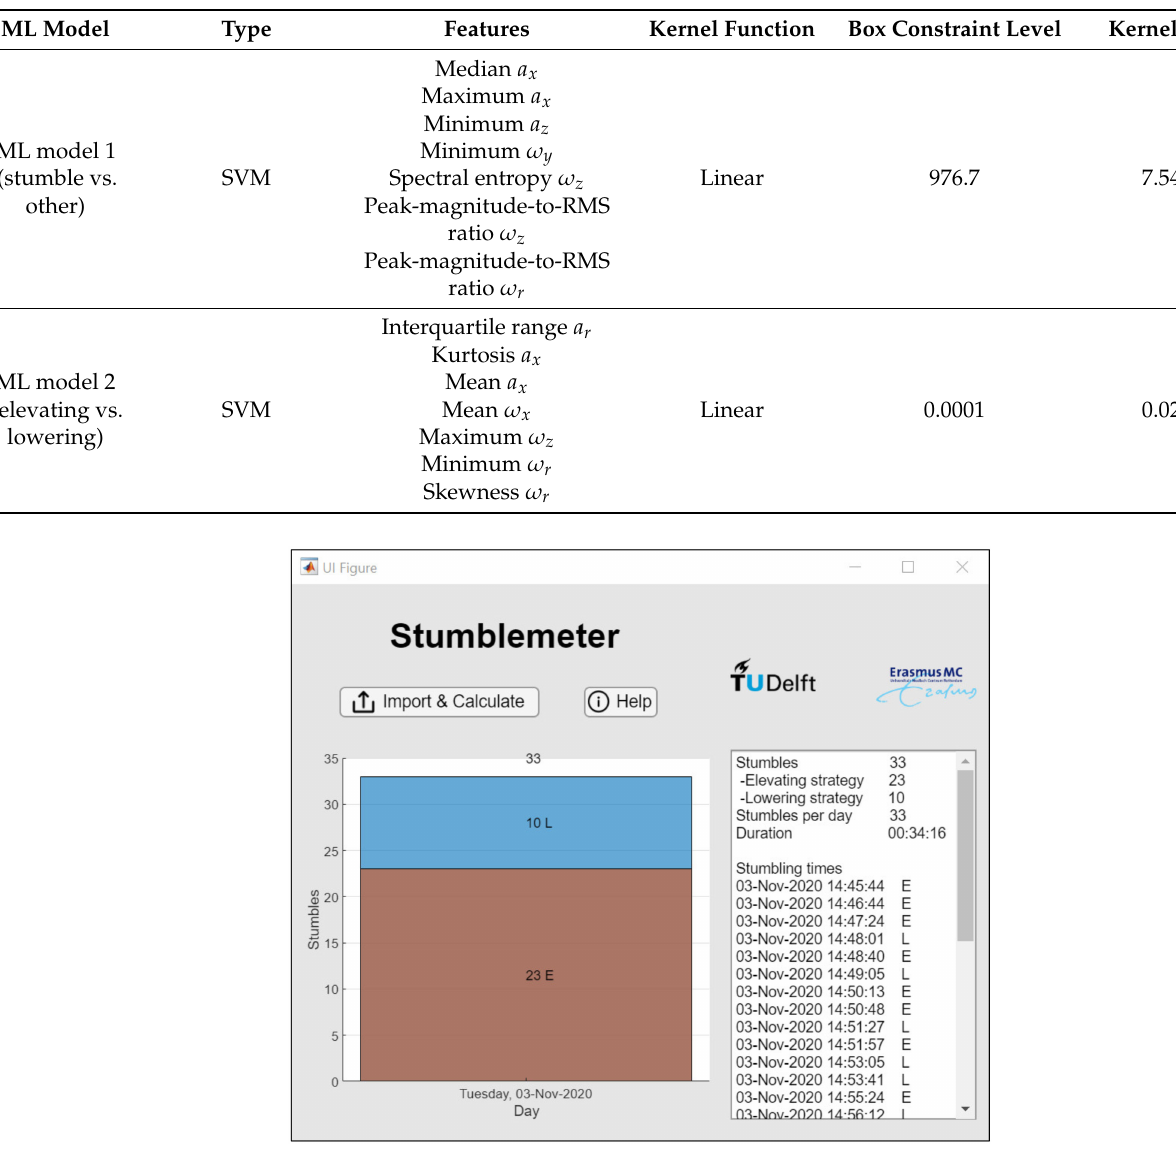
Table 10. Final models: features and hyperparameters.